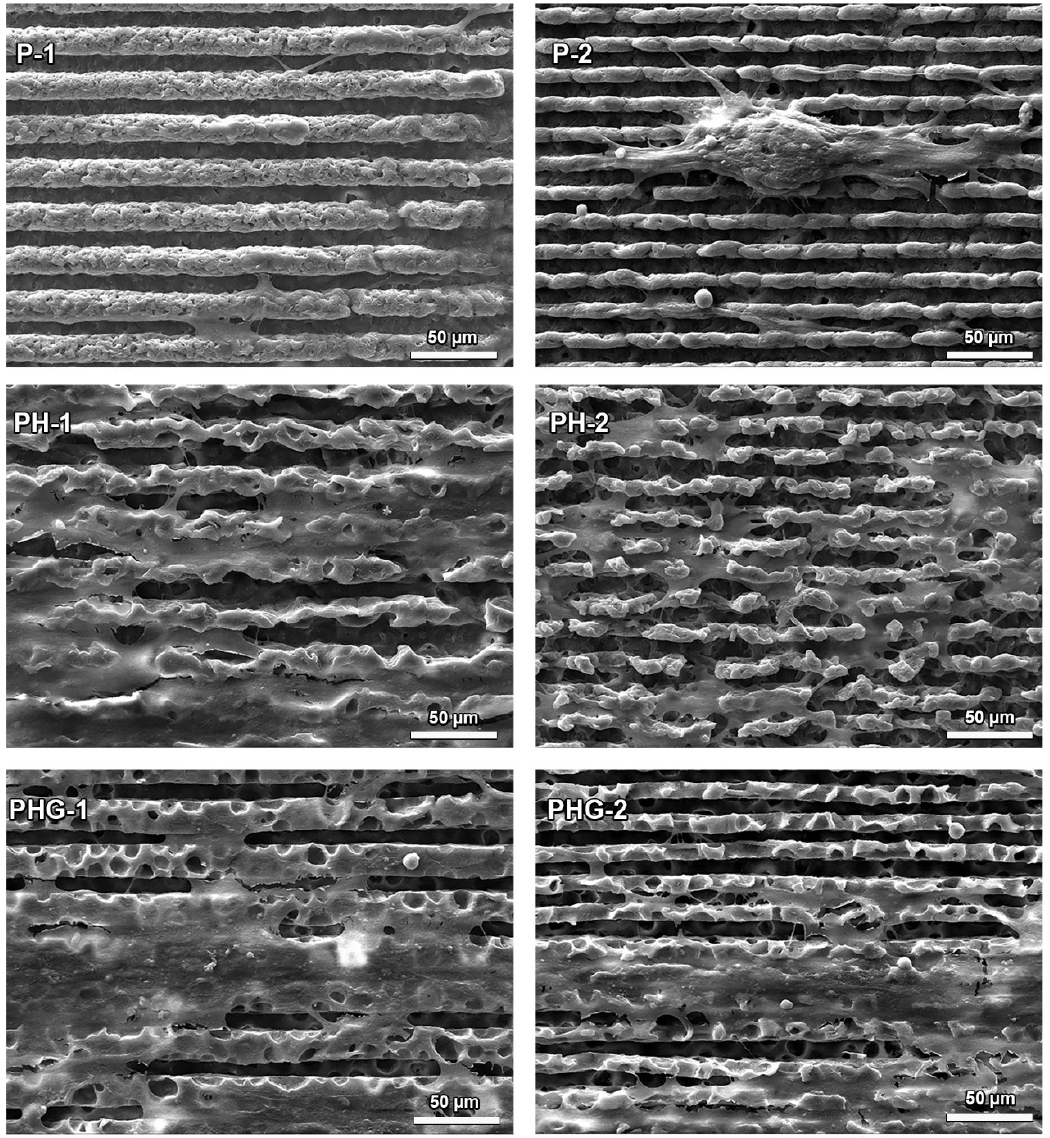
Figure 7. SEM images of human osteoblast cells cultured for 7 days on membranes of P, PH, PHG membranes with two different pattern sizes.